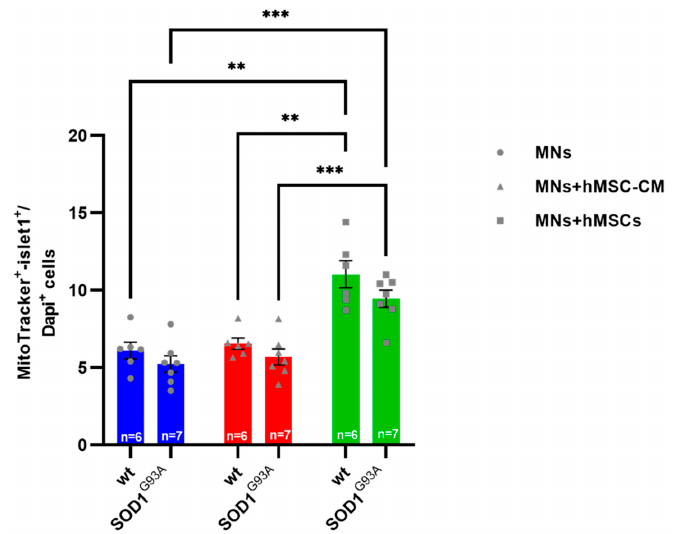
Figure 2. Increased number of MNs when co-cultured on hMSCs. Assessment of motor neuron numbers in primary MN monocultures compared to MN monocultures cultured in hMSC conditioned medium and MN-hMSC co-cultures. 10,000 wildtype or SOD1 G93A motor neurons were seeded on 10,000 hMSCs. After 5 DIV cells were fixed and stained for islet1, MitoTracker and DAPI. Double positive (islet1 + /MitoTracker + ) cells of 6–7 independent pooled experiments were counted and evaluated. Significant increase of SOD1 G93A and wildtype MN number when co-cultured on hMSCs as quantified by immunocytochemistry after 5 DIV ( n = 6–7). All analyses were performed by 2-way ANOVA: ** p < 0.01 and *** p < 0.001 and Tukey’s multiple comparisons post-hoc test. Single values are represented as repeated measurements together with mean ± SEM.